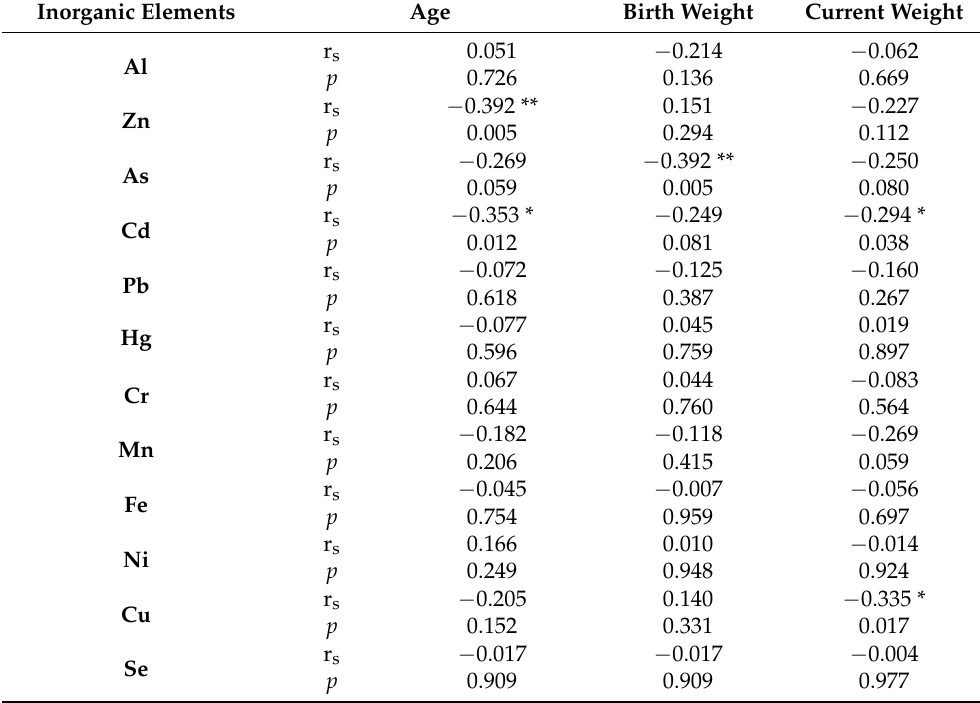
Table 5. Correlations of levels of inorganic elements in breast milk vs. child’s age, birth weight and current